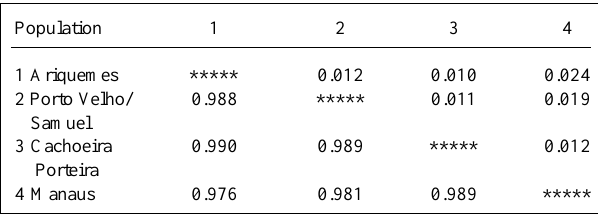
The values above the diagonal correspond to unbiased genetic distance and those below the diagonal correspond to unbiased genetic identity (Nei, 1978).